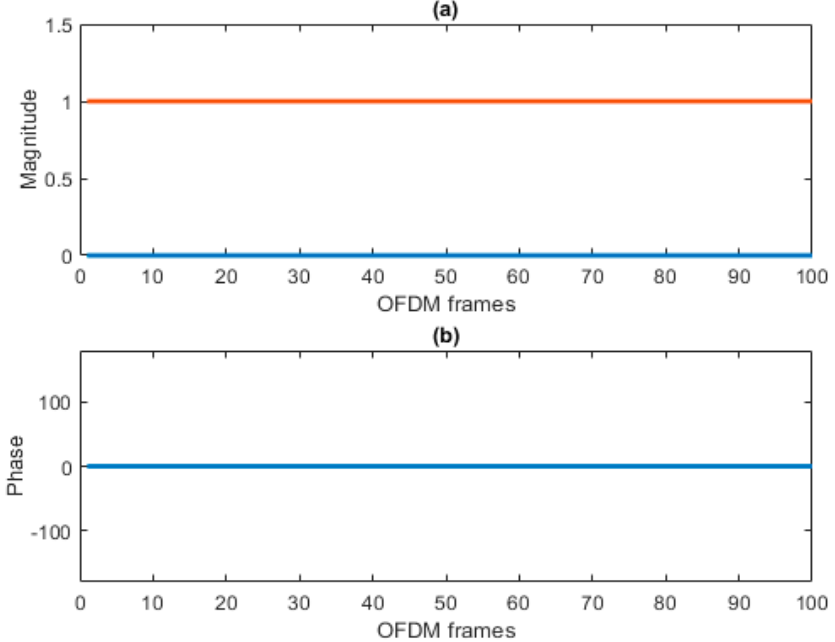
Figure 5. Ideal channel response ( a ) magnitude; ( b ) phase.